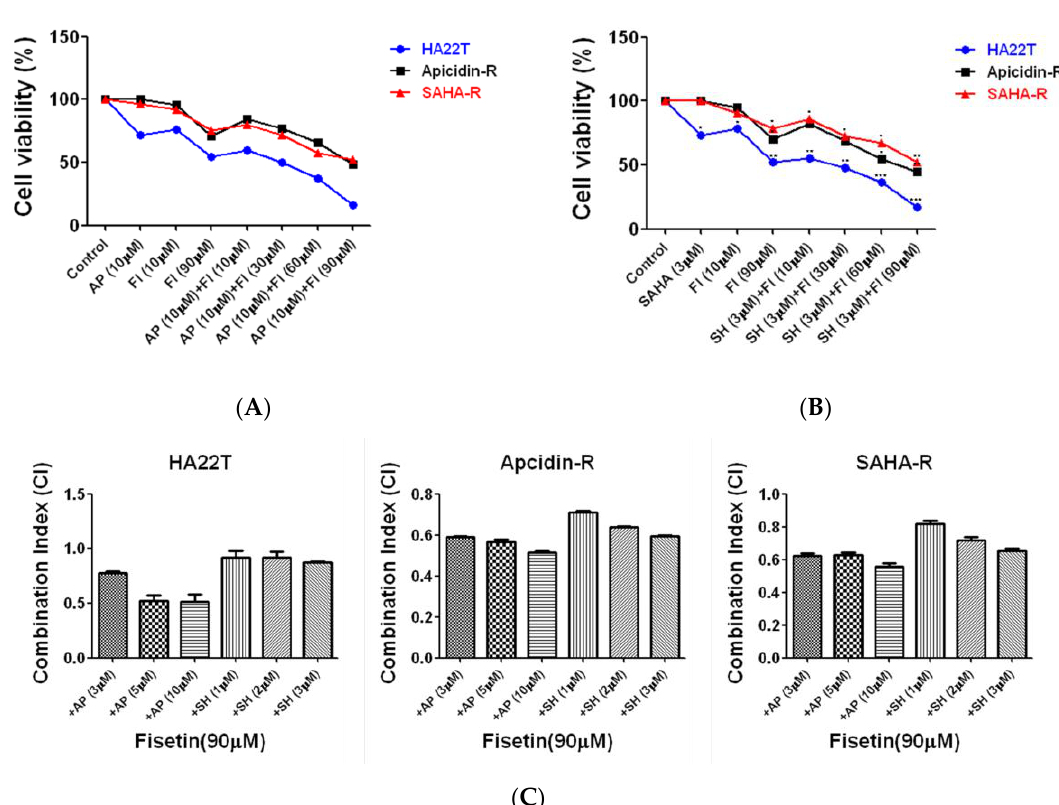
Figure 2. Fisetin enhances chemosensitivity in hepatocellular carcinoma (HCC) cells. Cell viability of HA22T, apicidin-R, and SAHA-R cells which were exposed to histone deacetylation (HDAC)